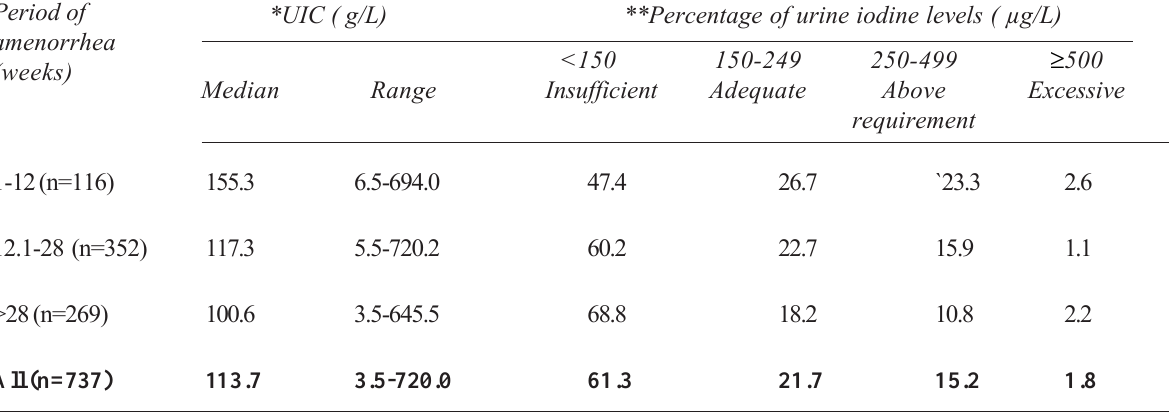
Table 3. Urinary iodine concentrations (UIC) of pregnant women according to trimester and distribution of